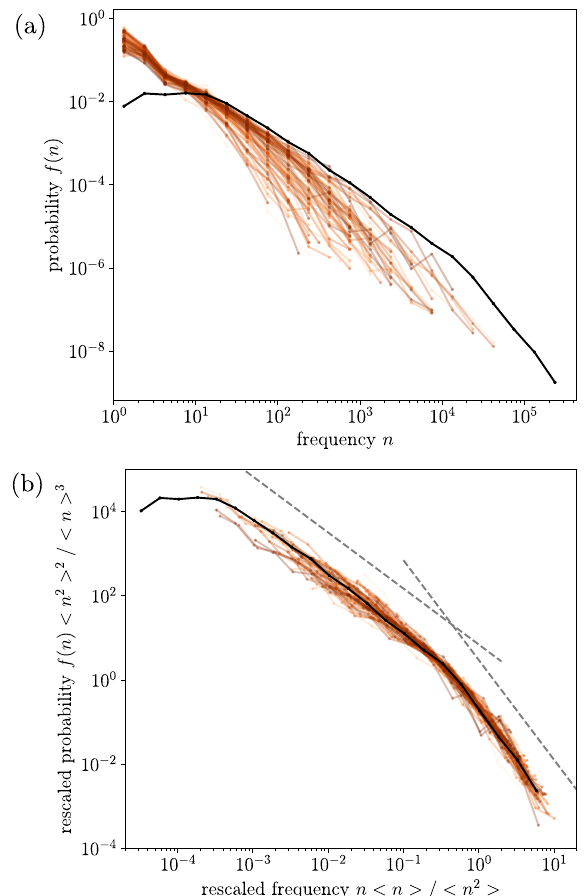
Figure 2. ( a ) Empirical probability densities of codeword frequency for the 76 composers, individually (orange-brown lines), and with all of them aggregated (black line). ( b ) Same distributions under rescaling of the axes, where a roughly similar shape emerges for every composer and the global corpus. Dashed straight lines are power laws with exponents 1.33 and 2.4, derived from the fit of the global